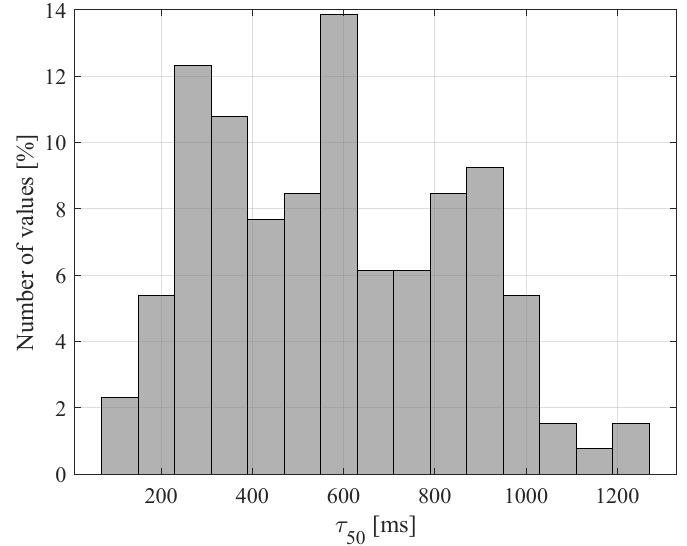
Figure 7. Histogram of the resulting coherence time values for all evaluated